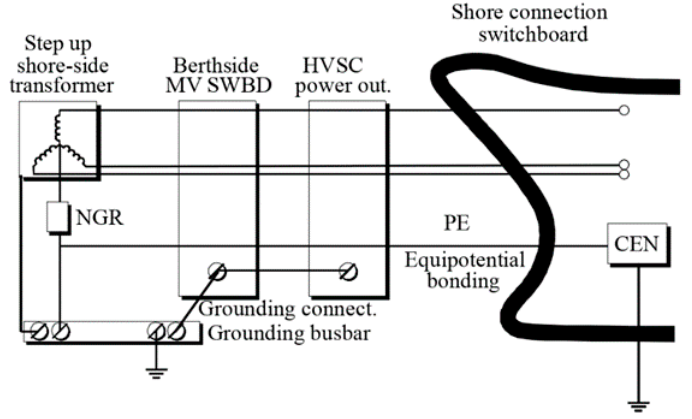
Figure 5. Neutral point connection to ground via a neutral grounding resistor (NGR) [16], where CEN is the common equipotential node and SWBD is short for switchboard. Reprint with permission [4927171511527] from Conference Proceedings: 2016 IEEE Industry Applications Society Annual Meeting; published by IEEE, Oct. 2016.